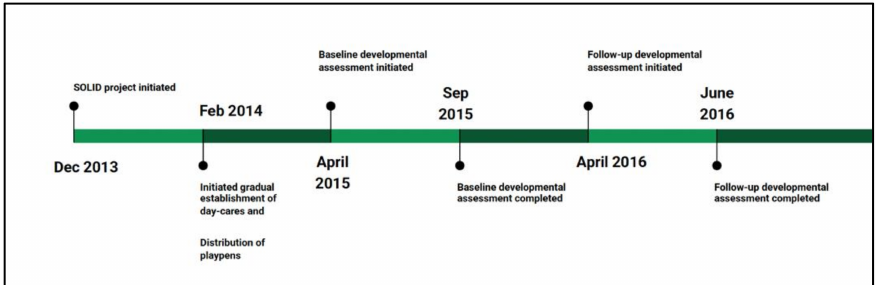
Figure 2. Timeline for data collection of developmental assessment